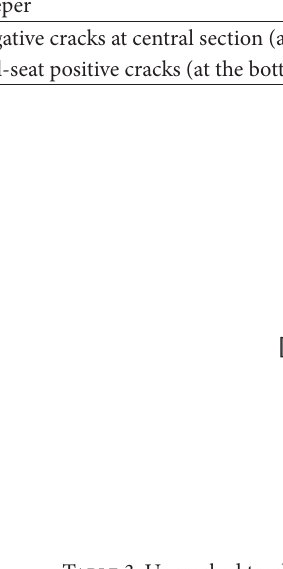
Table 3: Uncracked track model calibration.